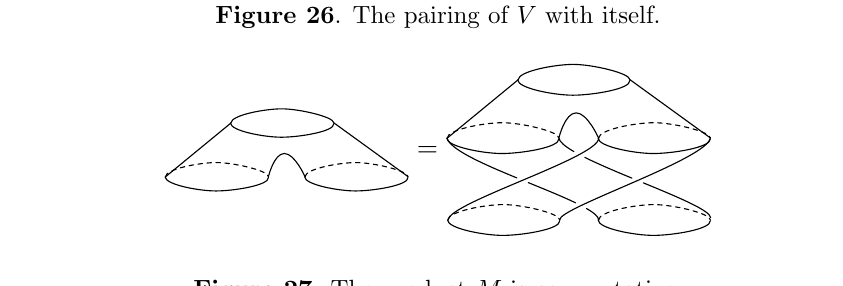
Figure 27 . The product M is commutative.